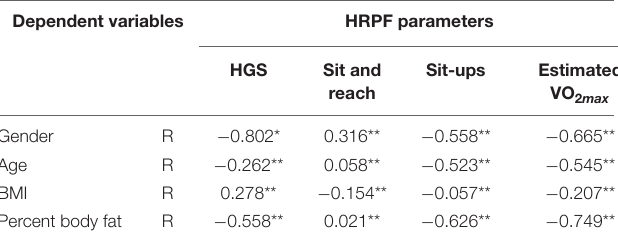
TABLE 2 | Correlation coefficients between dependent variables and HRPF parameters for the estimating regression model. Dependent